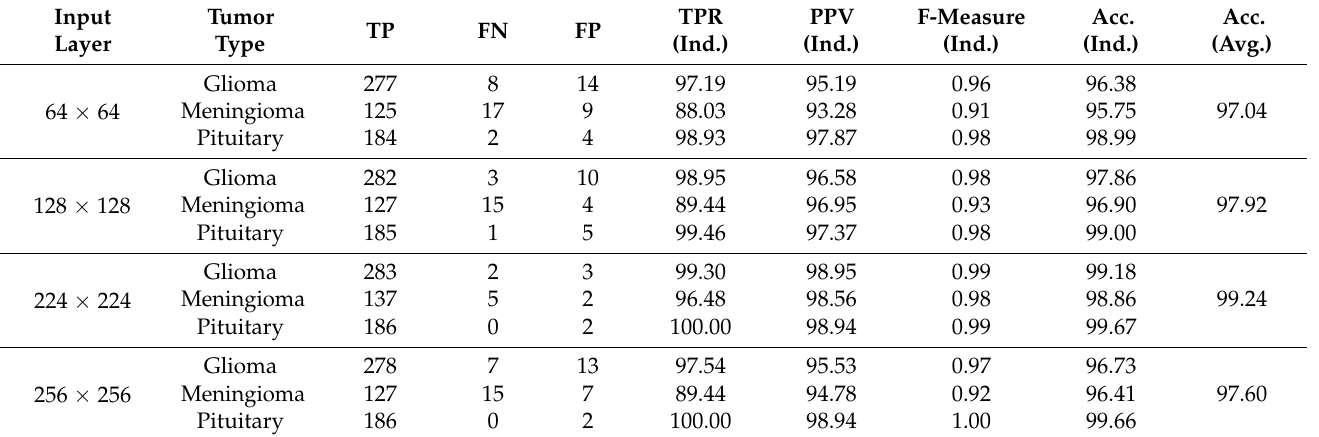
Table 7. Analysis of input layer size on the proposed model using SVM in the test phase (A-CE-MRI dataset, OvA coding scheme, and polynomial kernel ( P 3 )).